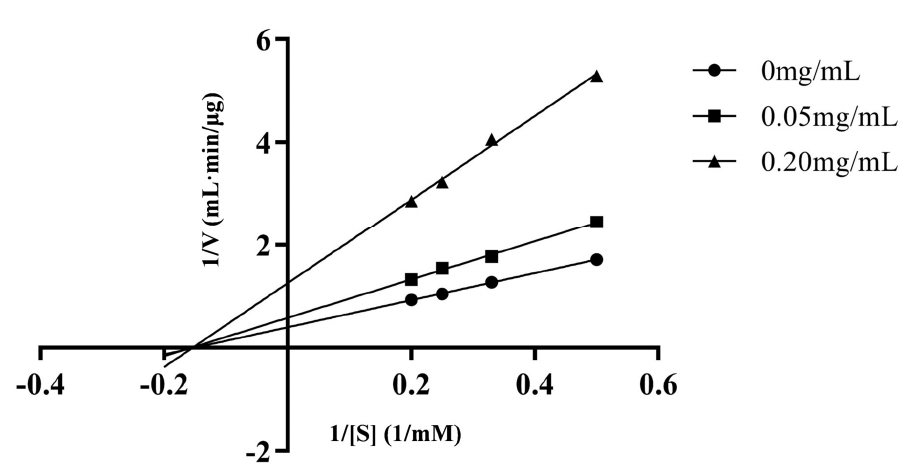
Figure 5. The MS/MS spectrum of the peptide VVVPQN.